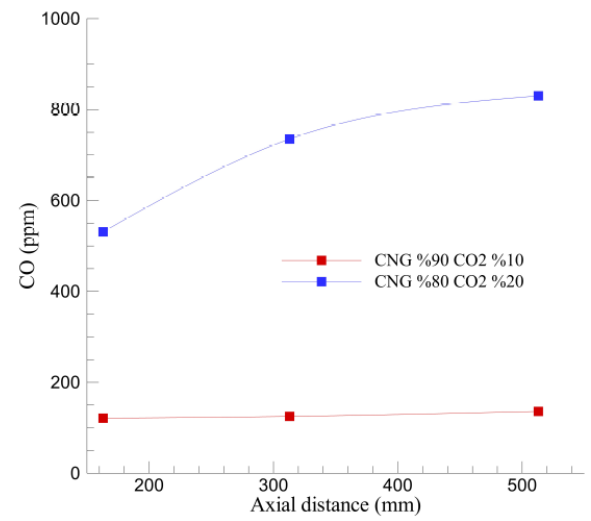
Figure 13: Axial CO emission profiles (Swirl number: 0.4, Equiva- lence ratio: 0.9).